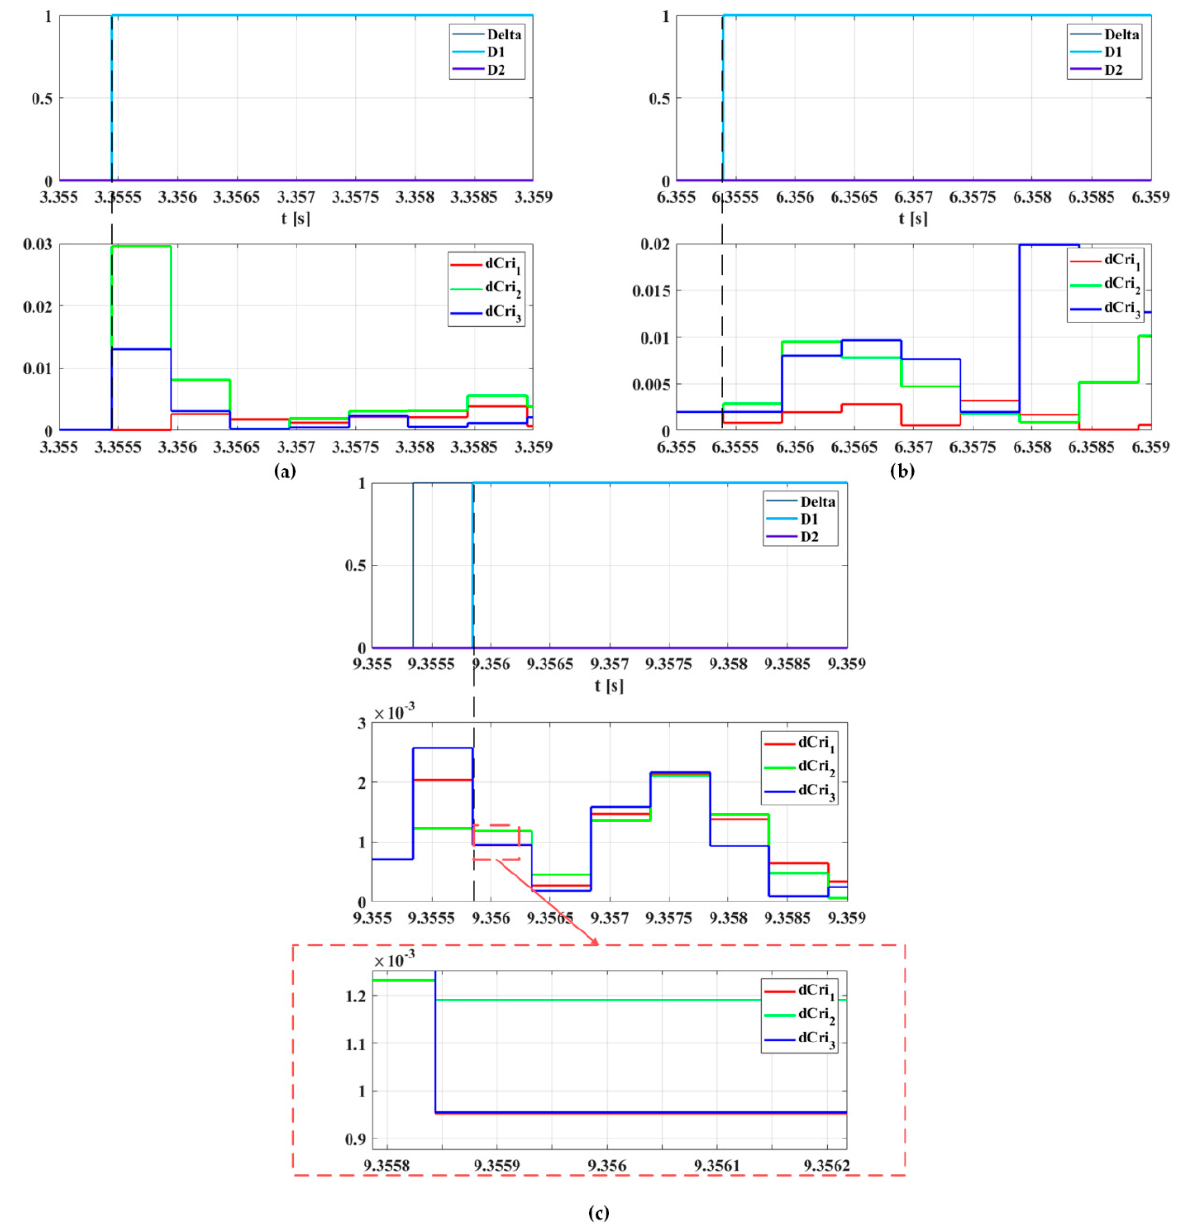
Figure 2. Detector responses and transients of marker errors during lack of signal: ( a ) measurement white Gaussian noise (70 dB); ( b ) variable gain; ( c ) (1.2 i a ) ; in phase A in experimental tests.